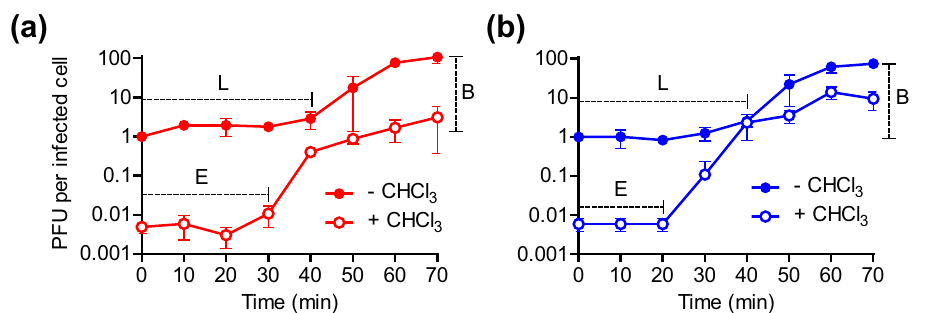
Figure 3. Both SA3821 and SA3821 M adsorbed to the host S. aureus cells via recognition of WTAs. ( a ) Phage spotting assay results and ( b ) phage adsorption assay results with S. aureus RN4220 wild-type (WT), ∆tagO :: erm mutant (∆ tagO ), and ∆tagO :: erm -complemented strain (+ tagO ). The numbers of unbound free phages against each host strain were expressed in percentages compared to the numbers of initial inoculated phages. (c) Adsorption kinetics of parent SA3821 and mutant SA3821 M . Host S. aureus CCARM 3821 was infected with phages, and unadsorbed virions in the culture supernatant were enumerated periodically through plaqueing assays. Results are expressed as mean and standard error of the mean. ** P < 0.01; *** P < 0.001; ns not significant.